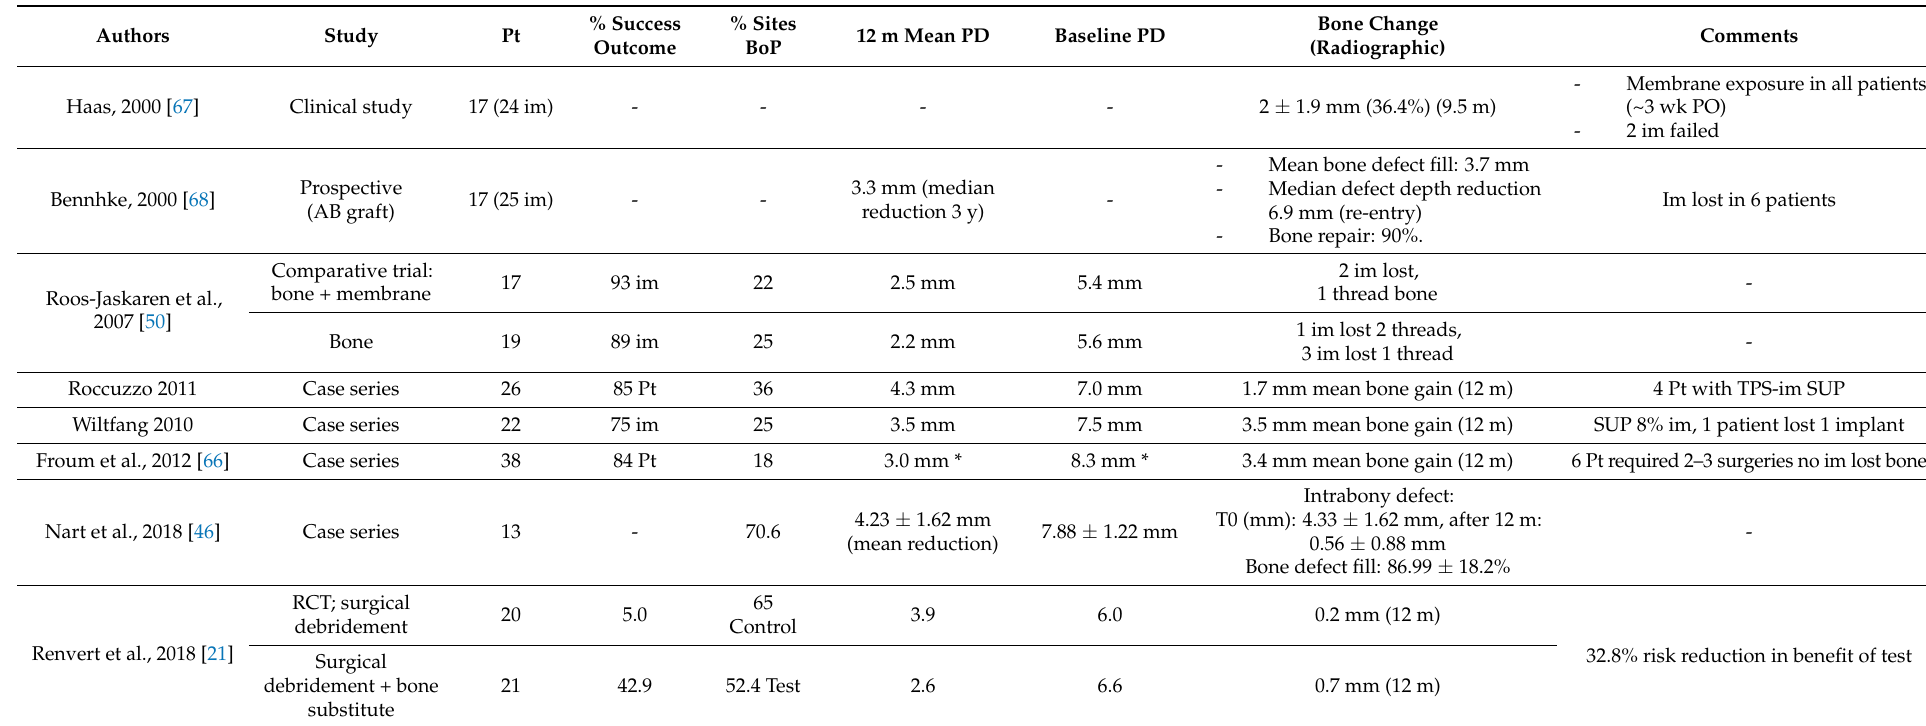
Table 3. Studies that reported on the number of patients (Pt) treated, % therapy success, mean probing depth (PD) change, % of bleeding and/or suppuration on probing, radiographic bone levels at 12 months after treatment. Successful outcomes are defined as: implant survival with a mean PD < 5 mm and no progressive bone loss 12 months after treatment. AB: Autogenous Bone; T0: Baseline; m: month; wk: week; Pt: patient; im: implant. Adapted from Ramanauskaite et al.